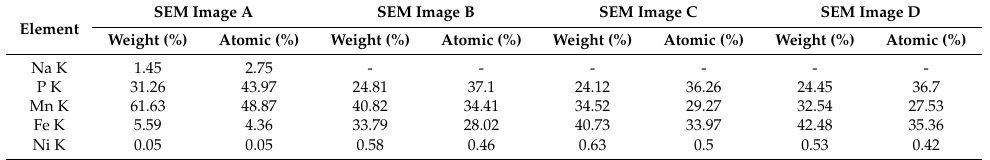
Table 10. The values of corrosion potential, current density, and corrosion rate estimated for samples that underwent the activation and passivation processes.